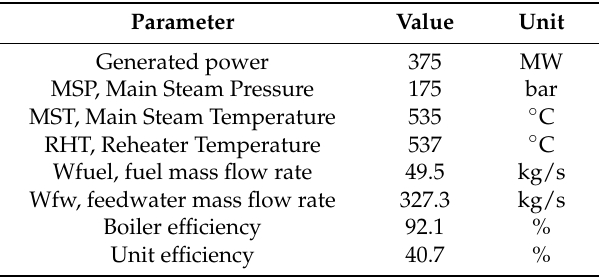
Table 1. The 375 MW oil-fired power plant model